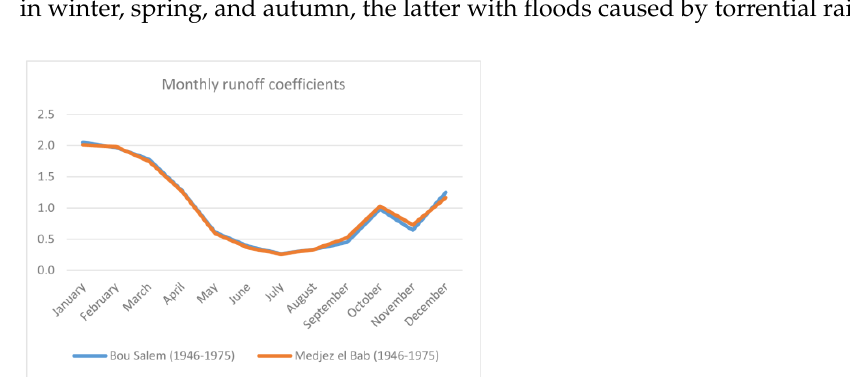
Figure 6. Monthly runoff coefficients of the Medjerda at the Bou Salem and Medjez el Bab